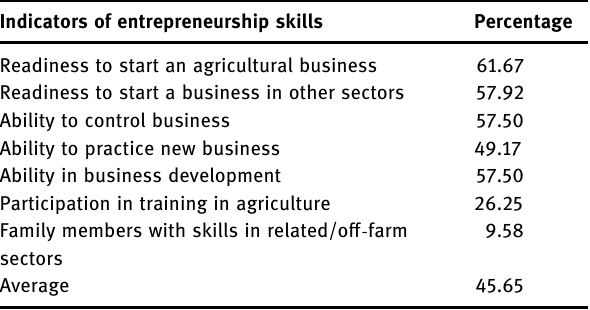
Indicators of entrepreneurship skills